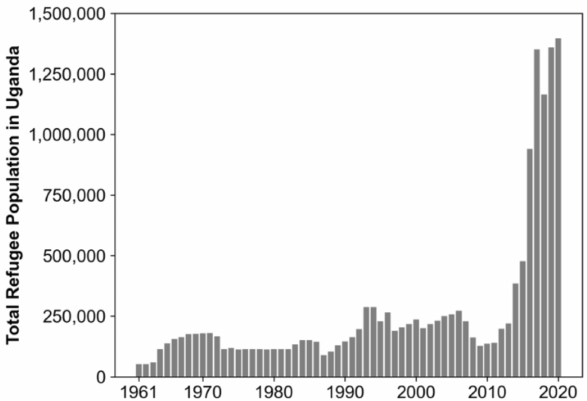
Figure 1. Total Refugee Population in Uganda from 1961 to 2020 based on UNHCR data at www. unhcr.org/refugee-statistics/download/?url=C06z (accessed on 23 March 2021). The 30 study refugee settlements have a median boundary area of 4 km 2 and range from 0.2 km 2 (Mireyi) to 790 km 2 (Bidi Bidi). Refugee settlements tend to grow